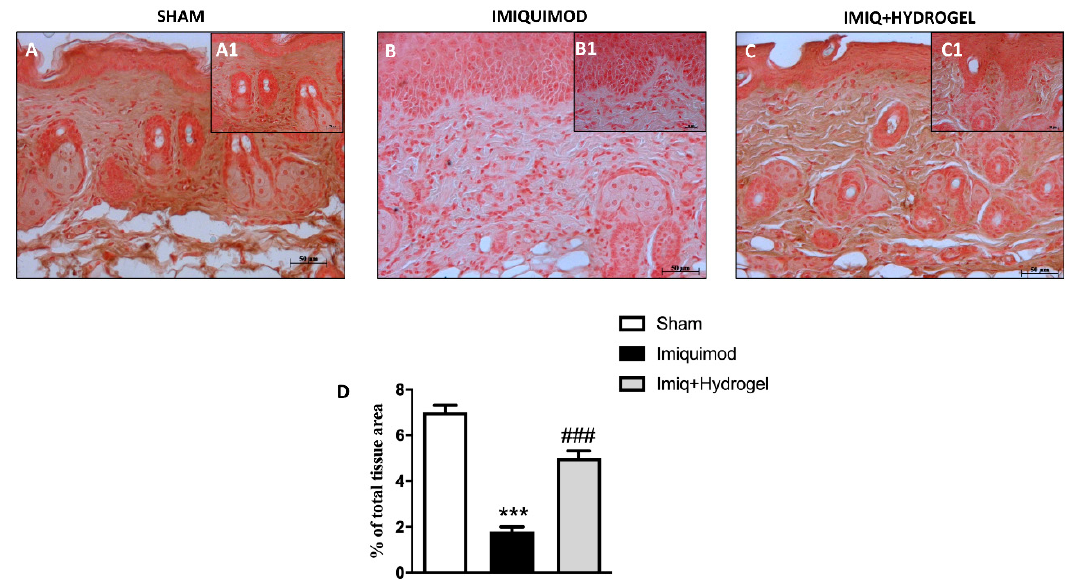
Figure 3. Effect of Hydrogel treatment on ZO-1 expression. The ZO-1 expression was analyzed using immunohistochemistry. Basal expression of ZO-1 ( A magnification 20 × , A1 magnification 40 × , D ) has been found in the tissues of sham-operated mice, IMQ administration reduced this expression ( B magnification 20 × , B1 magnification 40 × , D ), while Hydrogel treatment restored the expression of ZO-1 to almost basal levels ( C magnification 20 × , C1 magnification 40 × , D ). Data are representative of at least three independent experiments; One-Way ANOVA test. *** p < 0.001 vs. sham; ### p < 0.001 vs. IMQ.